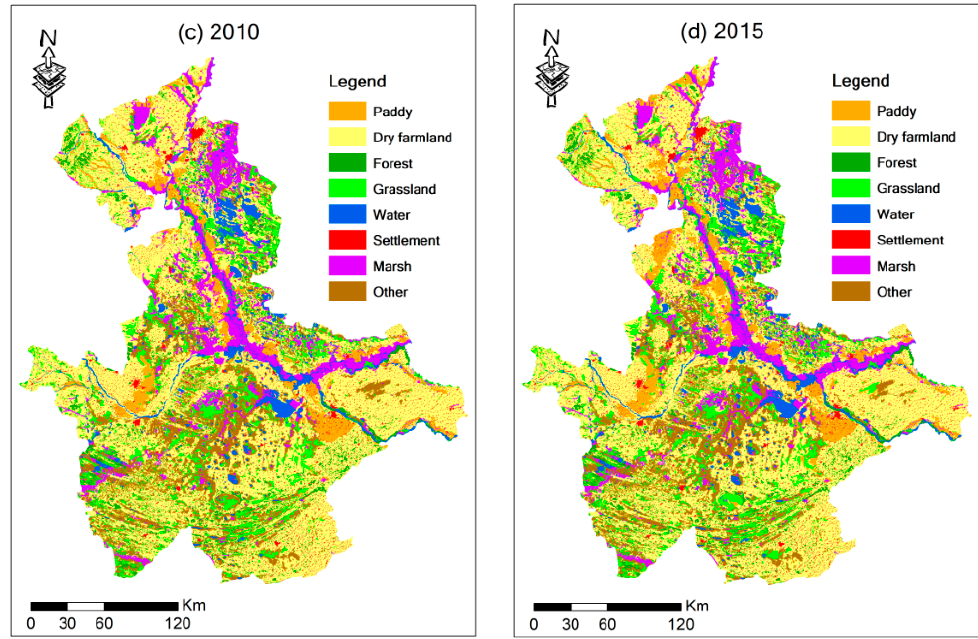
Figure 3. Land-use distribution in different years. ( a ) 1990; ( b ) 2000; ( c ) 2010; ( d ) 2015.